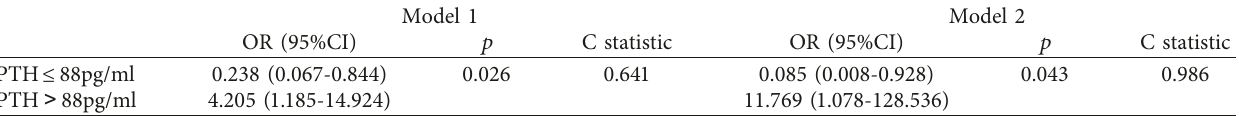
Table 5: Relationship between PTH and low SMI (Binary logistic regression